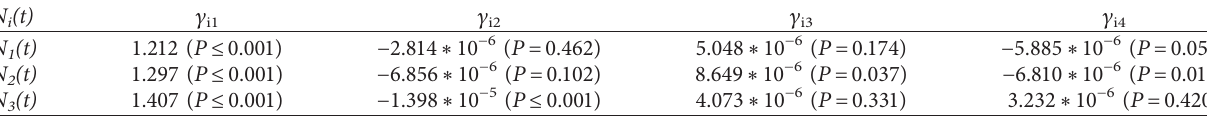
Table 6: Competitive analysis of grey transformation data based on the Lotka–Volterra